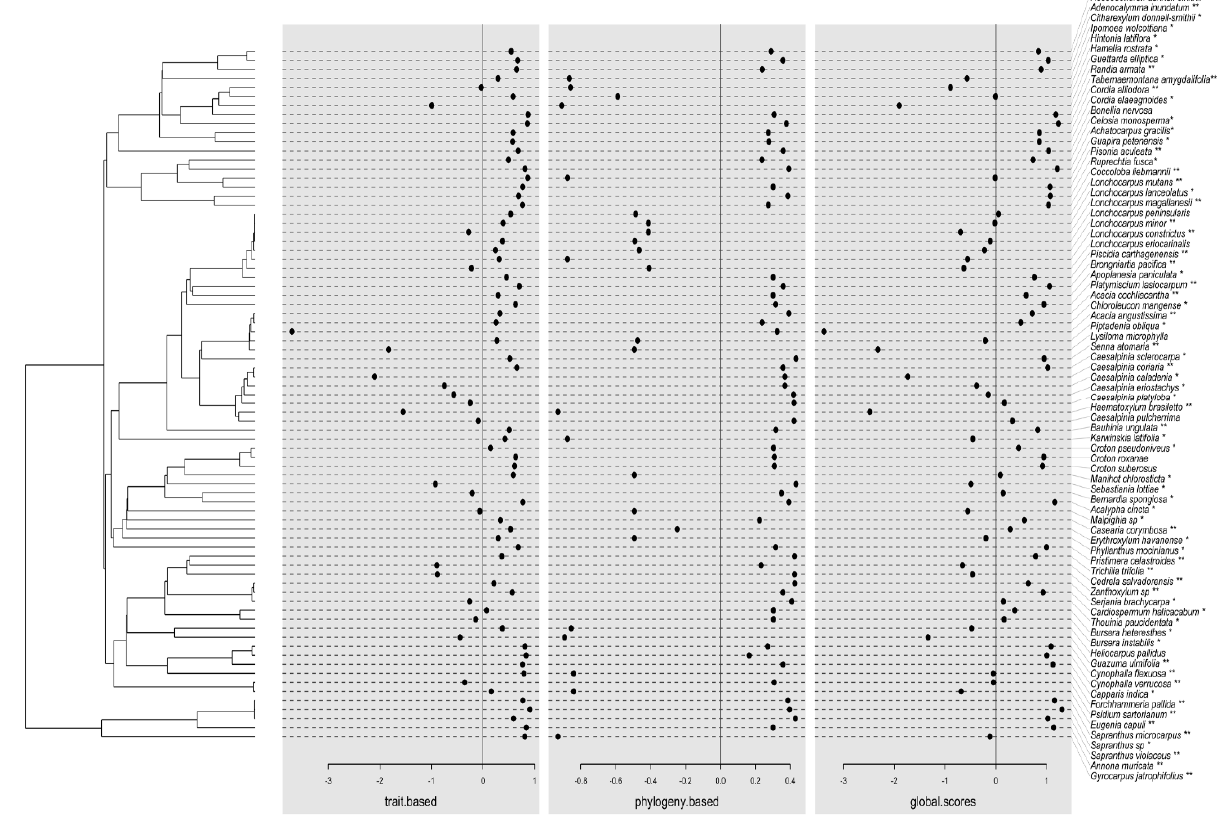
Figure 4. Phylogenetic tree and coordinates (dot plots) of species in the first axis of the extended RLQ analysis. The resulting coordinates (global.scores) of species were defined as a sum of a combination of traits variables (trait.based) and a combination of phylogenetic variables (phylogeny.based). * indicates species exclusively registered in old-growth forests, and ** indicates species exclusively registered in secondary forests.